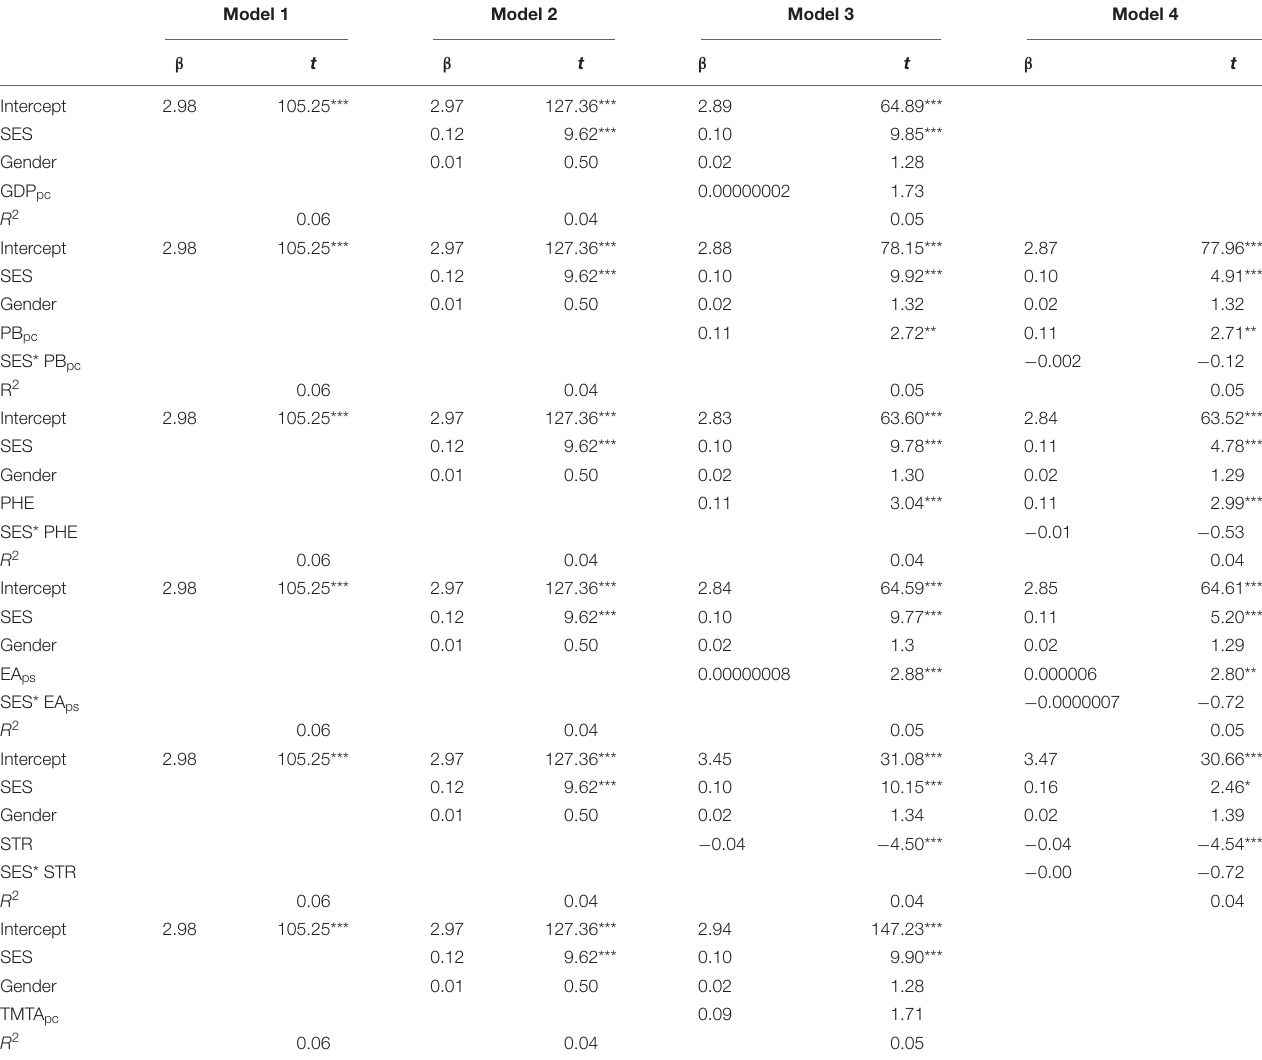
TABLE 2 | The effect of gender, SES and provincial factors on behavioral